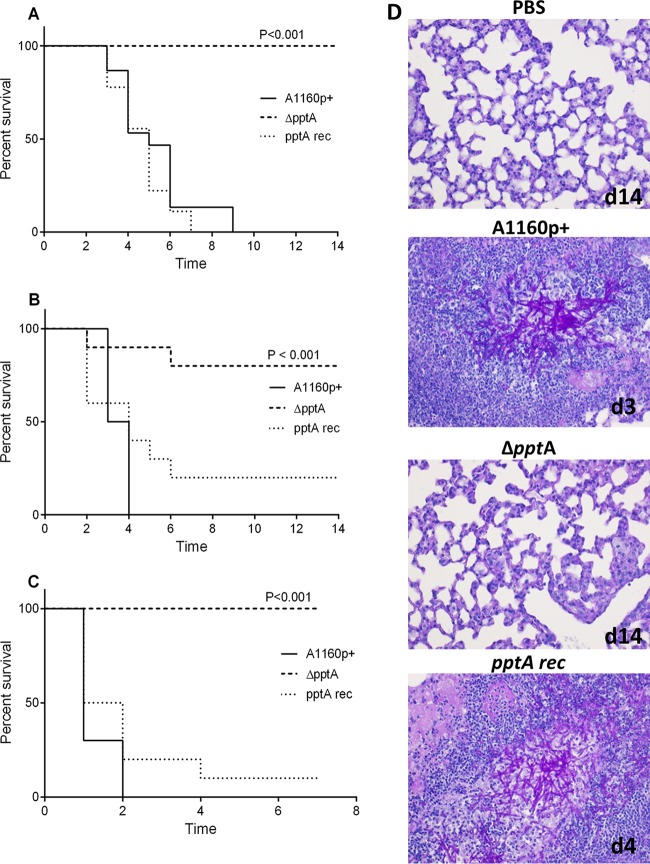
Assessing the effect of loss of pptA on virulence in murine infection models. Mice were infected with the parental (A1160p+), pptA null mutant (ΔpptA), or the reconstituted isolate (pptA rec). (A to C) Kaplan-Meier plots of results from mice treated via (A) intranasal infection with 2 × 104 spores after mice were rendered neutropenic by treatment with cyclophosphamide, (B) intranasal infection with 2 × 105 spores after cortisone-acetate treatment, or (C) intravenous infection with 1.3 × 105 spores. A log rank analysis was used to compare results after ΔpptA infection versus infection with the parental strain (A1160p+). In all cases (A to C), P values were less than 0.001. (D) Histopathology of representative sections of lungs from A. fumigatus-infected mice from the study shown in panel B. The presence of invasive fungal hyphae (pink), destructed lung tissue, and infiltration of immune cells (purple nuclei) were confirmed in lungs of mice infected with conidia from the parental strain, the pptA null isolate, or the reconstituted isolate. A lung section of a PBS sham-infected mouse is shown as a control.